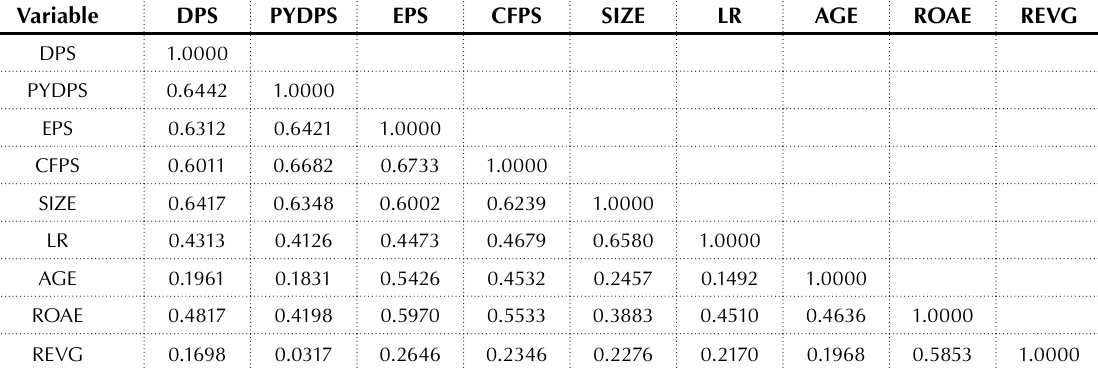
Table 3. Pearson correlation matrix